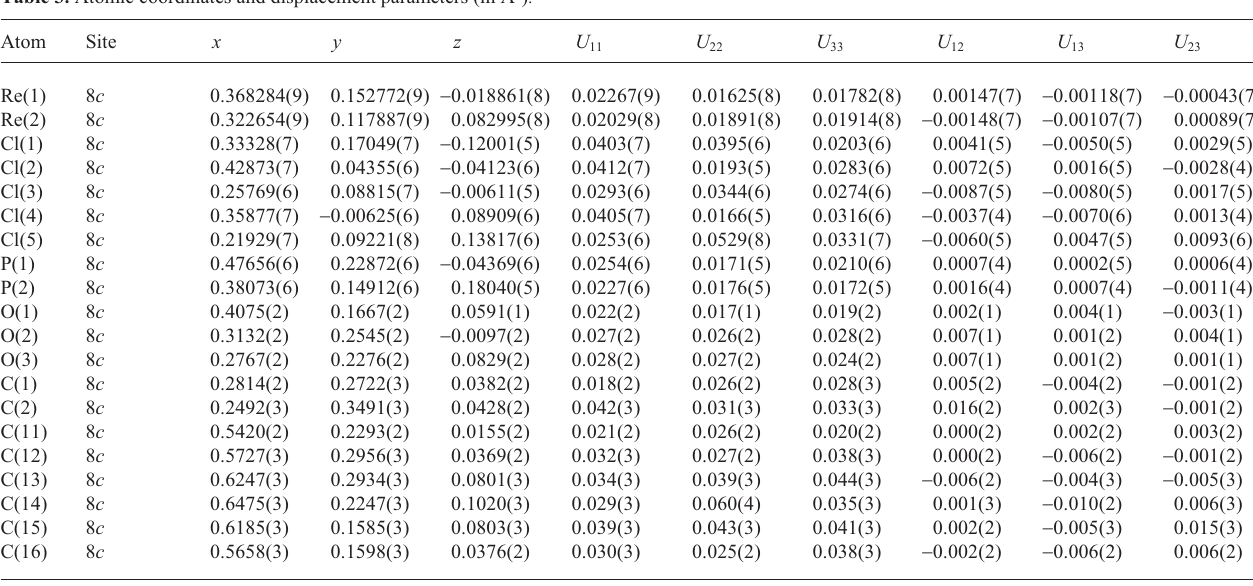
Table 3. Atomic coordinates and displacement parameters (in Å 2 )